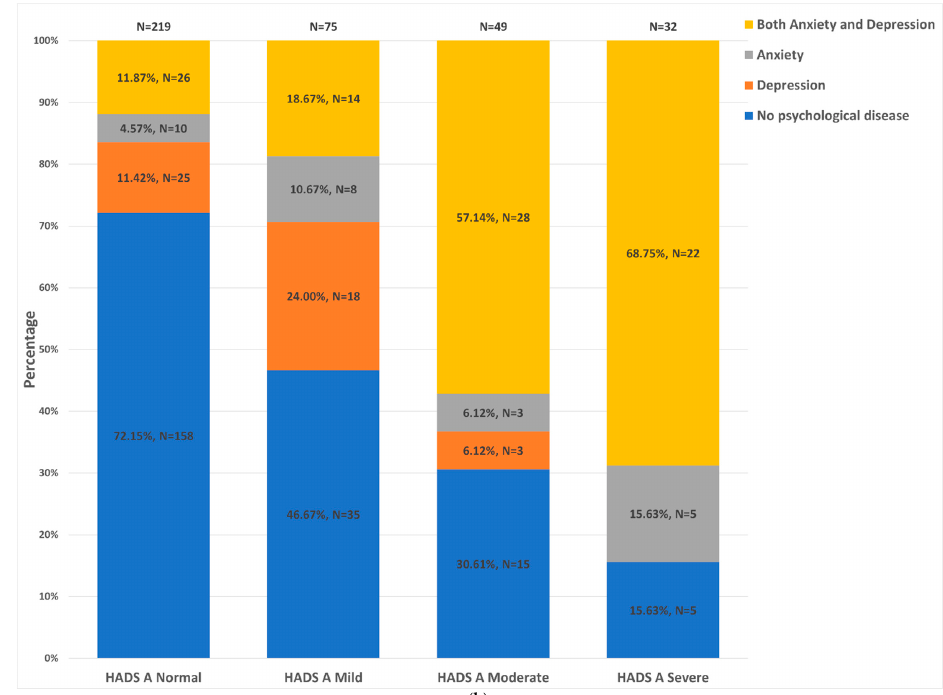
Figure 2. Distribution of the different patient groups across the HADS-D and HADS-A strata. ( a ). Distribution of HADS-D strata: HADS normal = HADS score of 0–7; HADS mild = HADS score of 8–10; HADS moderate = HADS score of 11–14; HADS severe = HADS score ≥ 15. ( b ). Distribution of HADS-D strata: HADS-D normal = HADS score of 0–7; HADS mild = HADS score of 8–10; HADS moderate = HADS score of 11–14; HADS severe = HADS score ≥ 15.